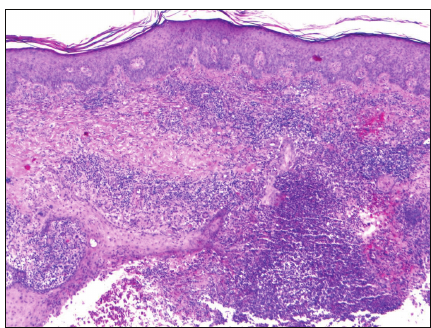
Figure 6: Histologic picture of the skin biopsy of one thigh lesion, showing pseudoepitheliomatous hyperplasia with suppurative gran-